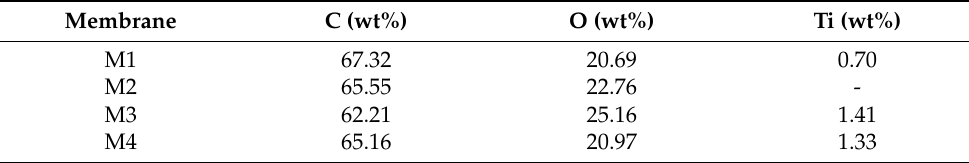
Table 3. EDX study of the membrane samples.